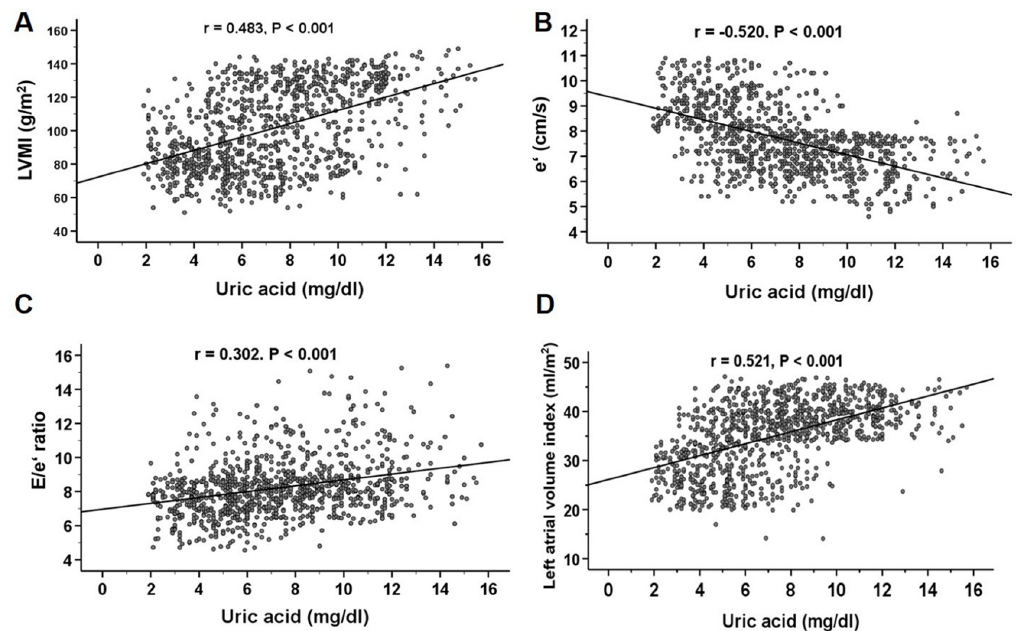
Fig 1. Correlations between SUA levels and LVMI (A) , e’ (B) , E/e’ (C) , and left atrial volume index (D) in patients with pre- dialysis CKD (n = 1025). The SUA level correlated positively with the LVMI, E/e’ ratio, and left atrial volume index and correlated negatively with the e’. CKD, chronic kidney disease; E, early mitral inflow velocity; e’, peak early mitral annular velocity; LVMI, left ventricular mass index; SUA, serum uric acid.